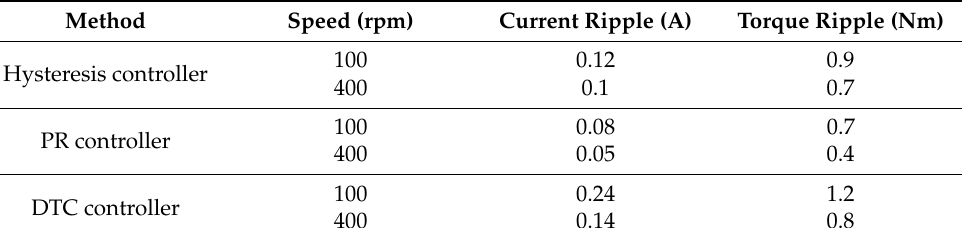
Table 4. Currents and torque ripples for different speed range for the three proposed control techniques.